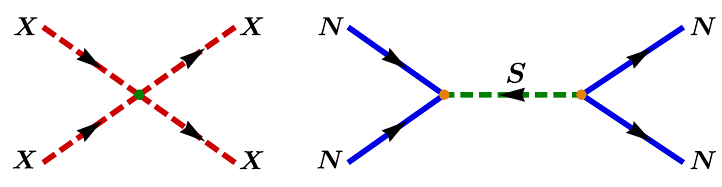
Figure 10 . The dominant Feynman diagrams of DM self-interacting processes for X and N , where the other processes can be obtained by rotating these